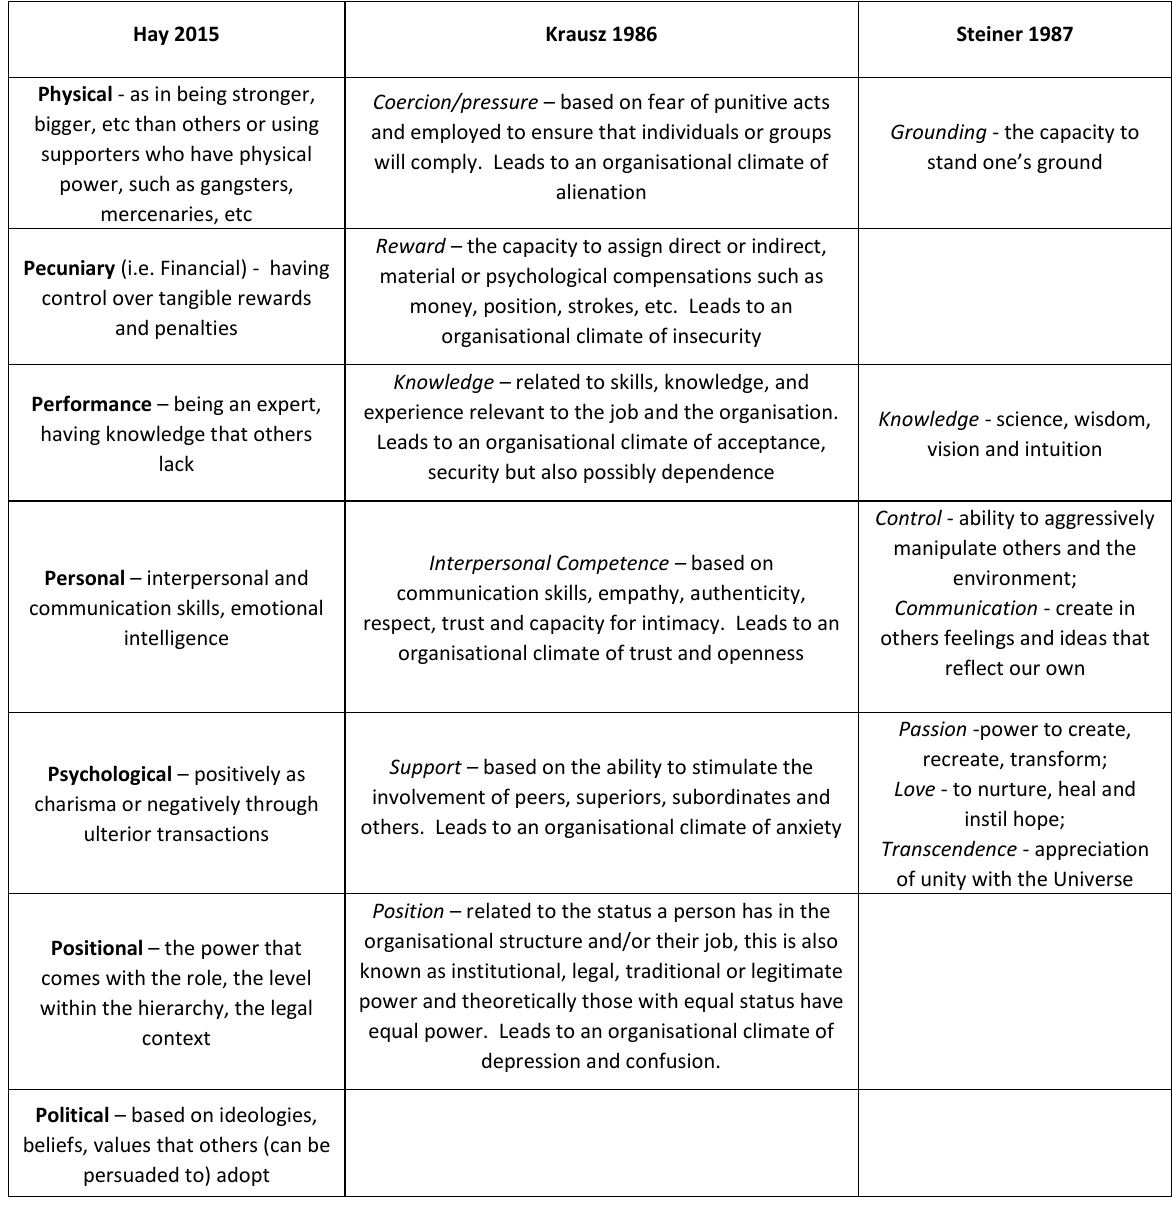
Table 1 : Power Potentials (Hay,